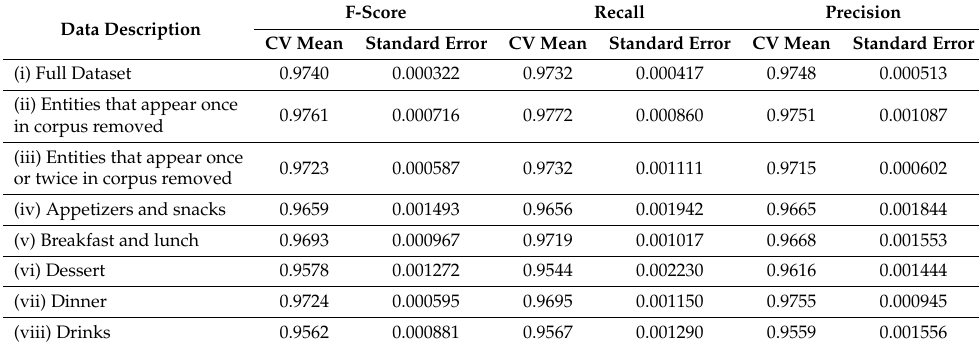
Table 3. Results for the hybrid model, FooDCoNER, assessed with a 10-fold CV. Datasets include (i) full corpus data, (ii) data with entities that appear just once are removed, (iii) data with entities that appear just once or twice are removed and (iv) appetizers and snacks, (v) breakfast and lunch,